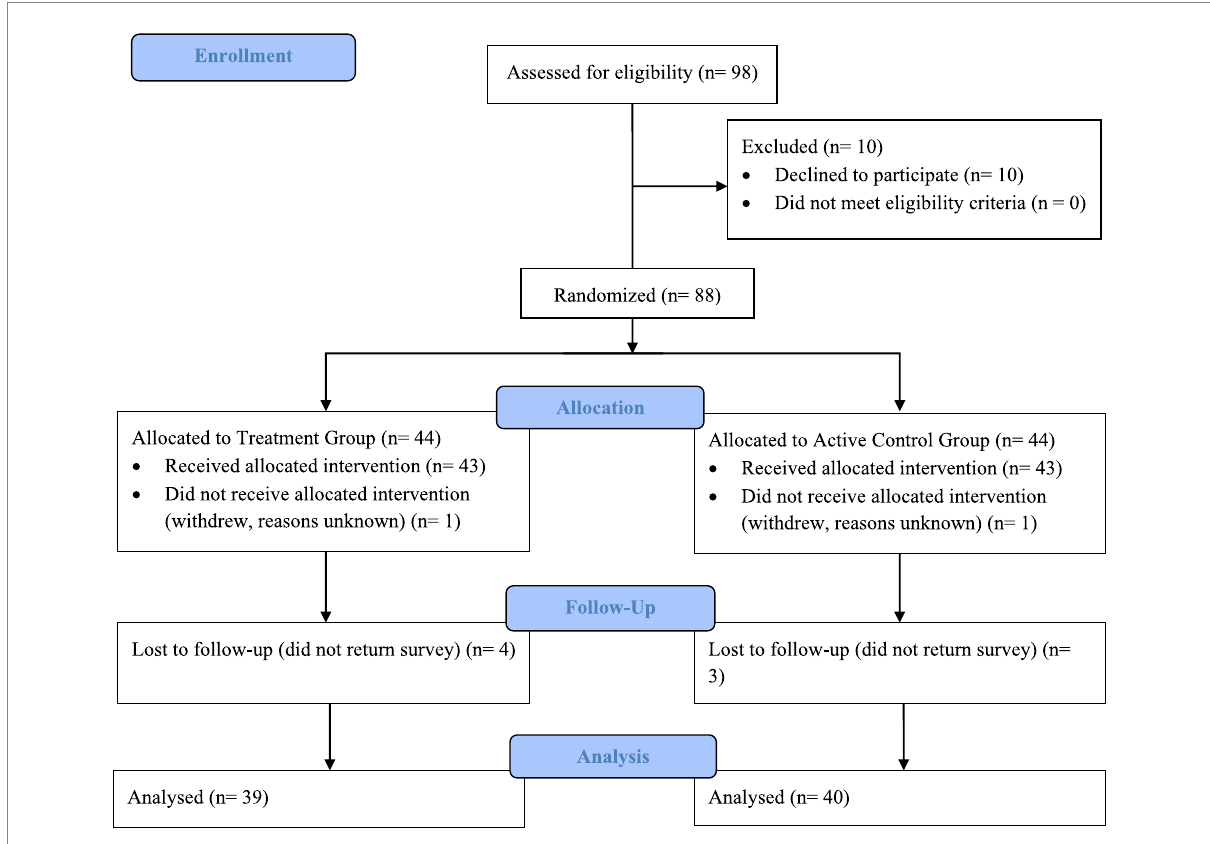
FIGURE 1 CONSORT (2010) flow diagram describing the composition of the study sample at each stage of the RCT.